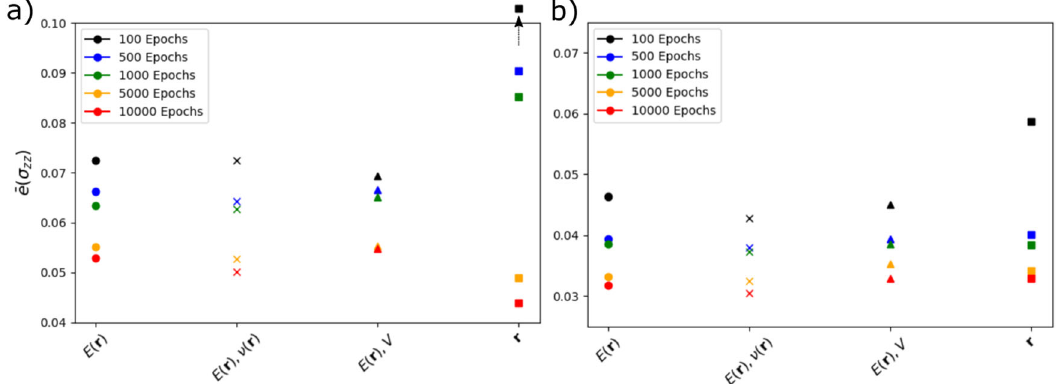
Fig. 3 Summary of learning rates for various nodal features included in the GNN surrogate models. Comparison of learning rates using various mechanical and microstructural descriptors for nodal features within the GNN surrogate models for a LSHR and b Ti-7Al.